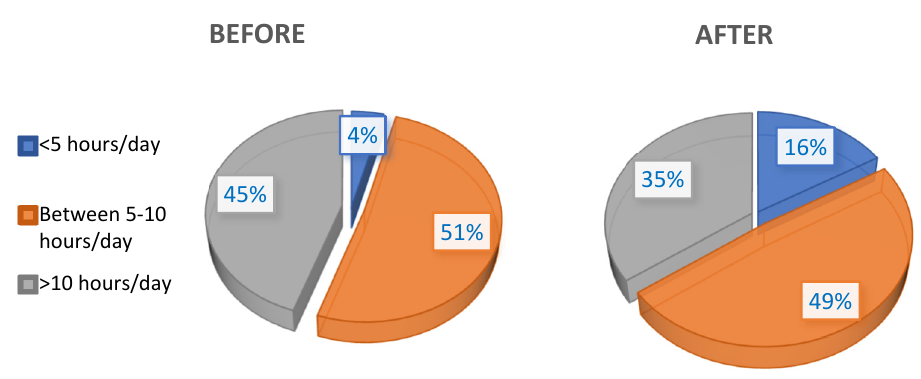
Figure 2. Hours of contact lens wear before and after the pandemic.